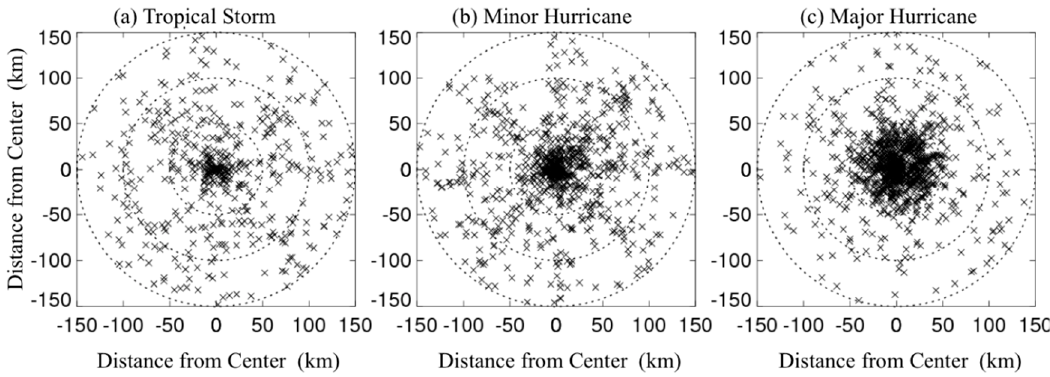
Figure 1. Plan view of the dropsonde distribution in the azimuth-radial plane relative to the storm center for ( a ) tropical storms, ( b ) minor hurricanes, and ( c ) major hurricanes, respectively.